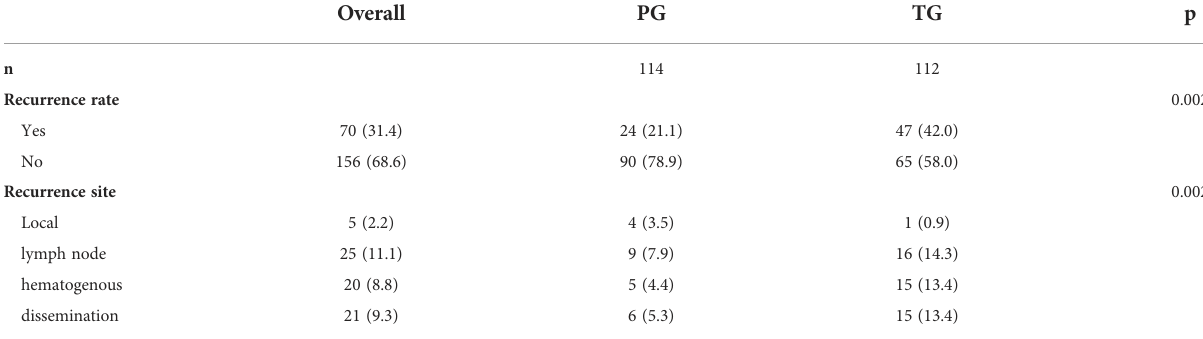
TABLE 5 A comparison of the recurrence between the PG and the TG groups. Overall